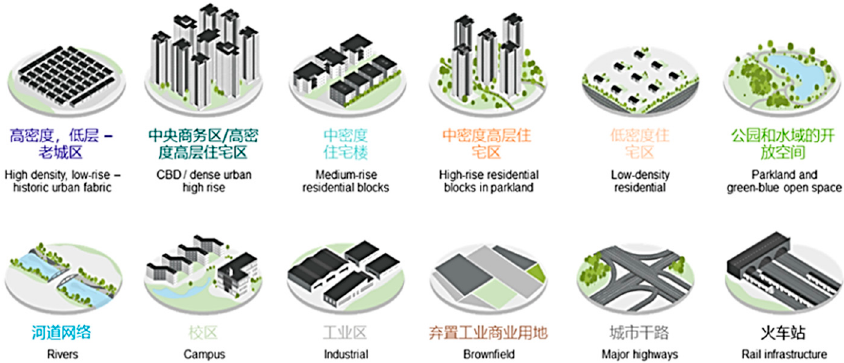
Figure 11. Land characterization of urban typologies of Shanghai.